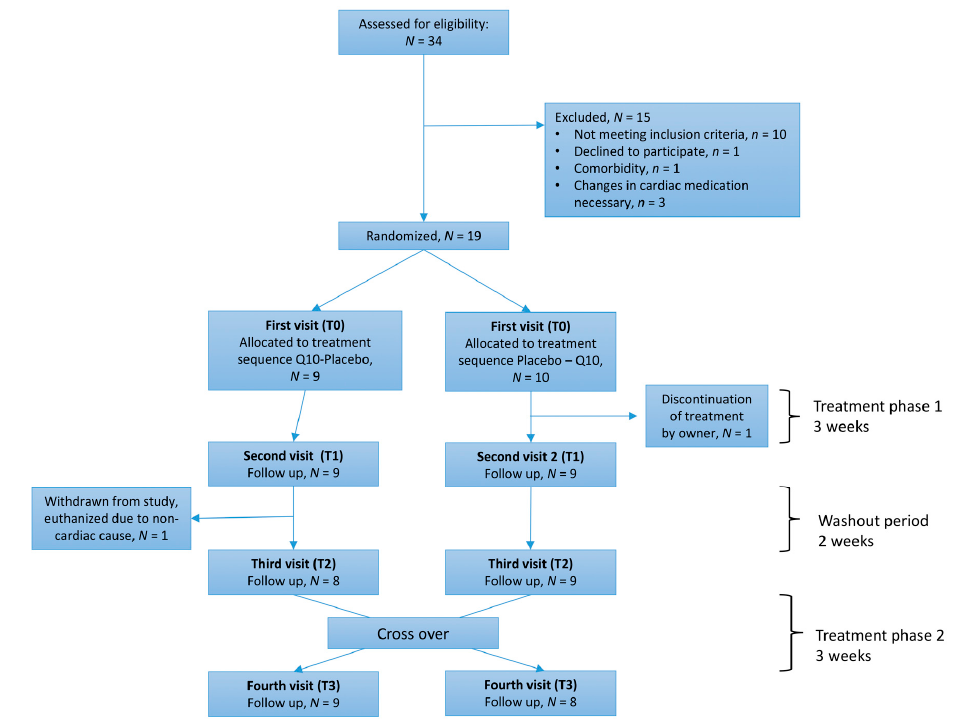
Figure 1. Flowchart of randomized placebo-controlled crossover study design. A modified CONSORT template [21] was used. Nineteen Cavalier King Charles Spaniels were randomized to one of two treatment arms: Q10 first, placebo second, or placebo first, Q10 second. Seventeen dogs completed the entire study.